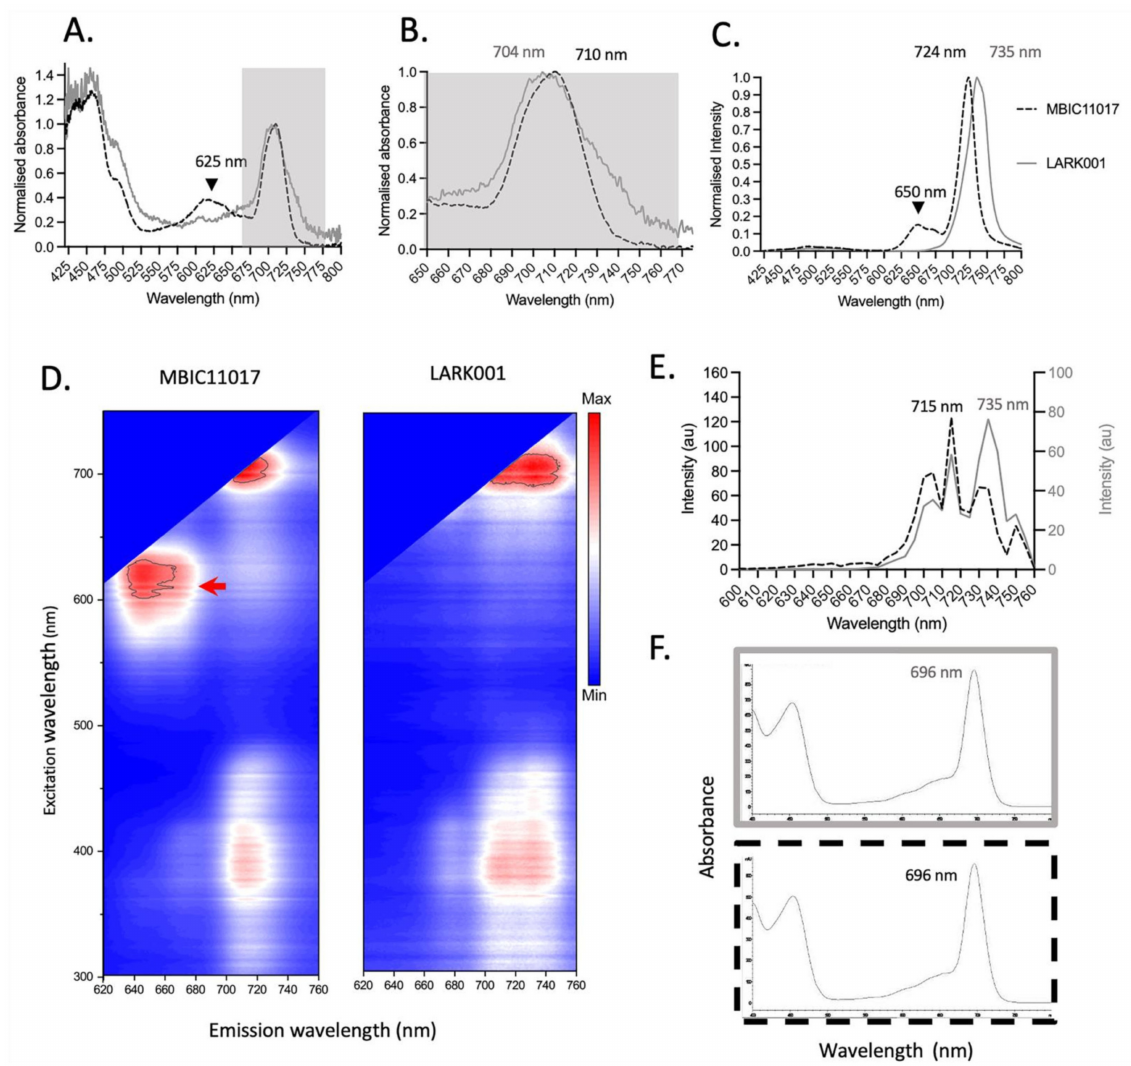
Figure 4. Absorbance spectra and fluorescence spectra of A. marina MBIC11017 vs. A. marina LARK001 grown in NIR. ( A ) Absorption spectra of both strains indicate differences between the two stains. At 625 nm (black arrow), a peak is present in the MBIC11017 strain that is not present in the LARK001 strain. Differences in the Chl d absorption region are also present (grey boxed region). ( B ) The grey boxed region from Panel A is magnified to further highlight the difference in peak Chl d absorption— 704 nm for LARK001 and 710 nm for MBIC11017. ( C ) The emission profiles for each strain reveal a peak at 650 nm (black arrow) that is unique in the MBIC11017 strain, whilst the Chl d emission peaks differ substantially, with the peaks at 724 nm and 735 nm for MBIC11017 and at 735 nm for LARK001 strain. ( D ) An excitation emission matrix shows a unique spectral component (excitation max. approx. 625 nm and emission max. approx. 640 nm) in the MBIC11017 strain. The LARK001 strain exhibits two distinct emission profiles for Chl d at 718 nm (approx.) and 735 nm (approx.). Only one emission profile at approx. 718 nm is evident for the MBIC11017 strain. ( E ) Hyperspectral confocal scan (top panel) confirms the evidence of two emission peaks in LARK001, with the 735 nm peak being the major contributor in this strain. The same two peaks are evident in the MBIC11017 strain, but the 715 nm peak is the major peak. ( F ) The grey and black dashed panels reveal no difference in the absorbance profiles in the Chl d fraction that was purified by HPLC for each